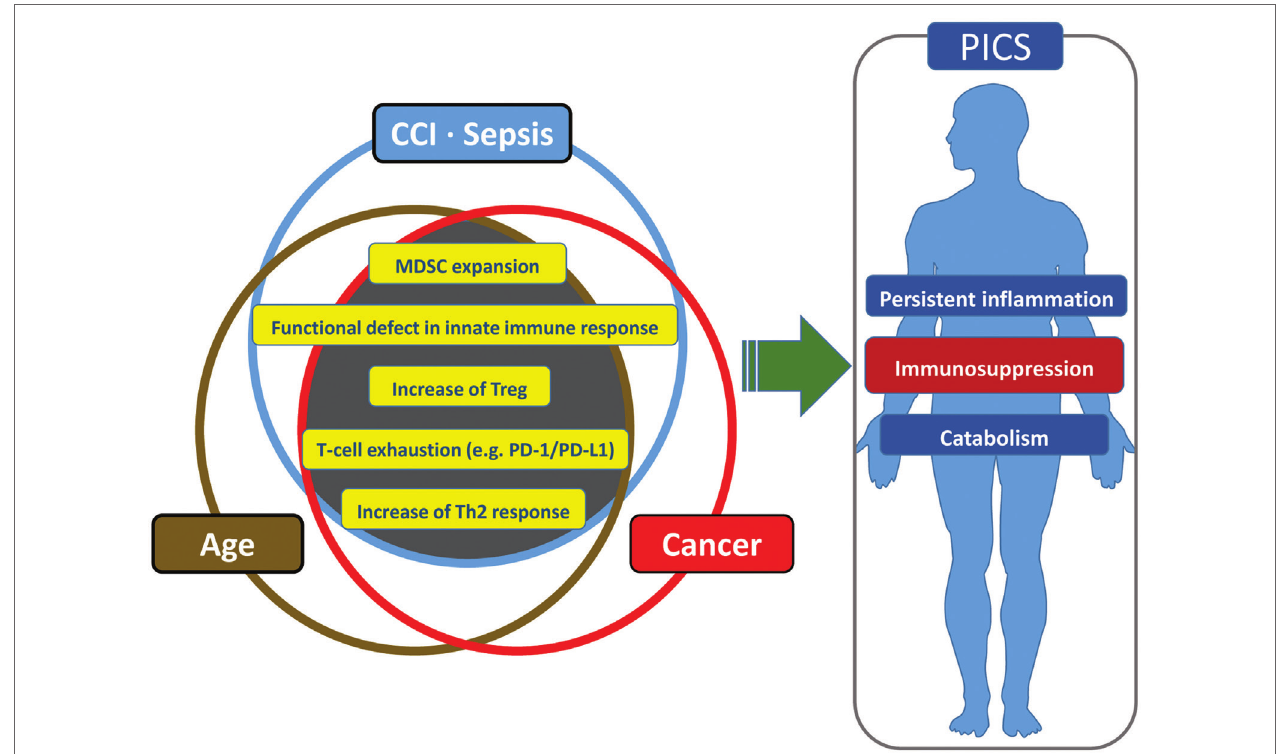
FiGURe 4 | Similarities and redundancies in the pathophysiology of patients with sepsis, cancer, and advanced